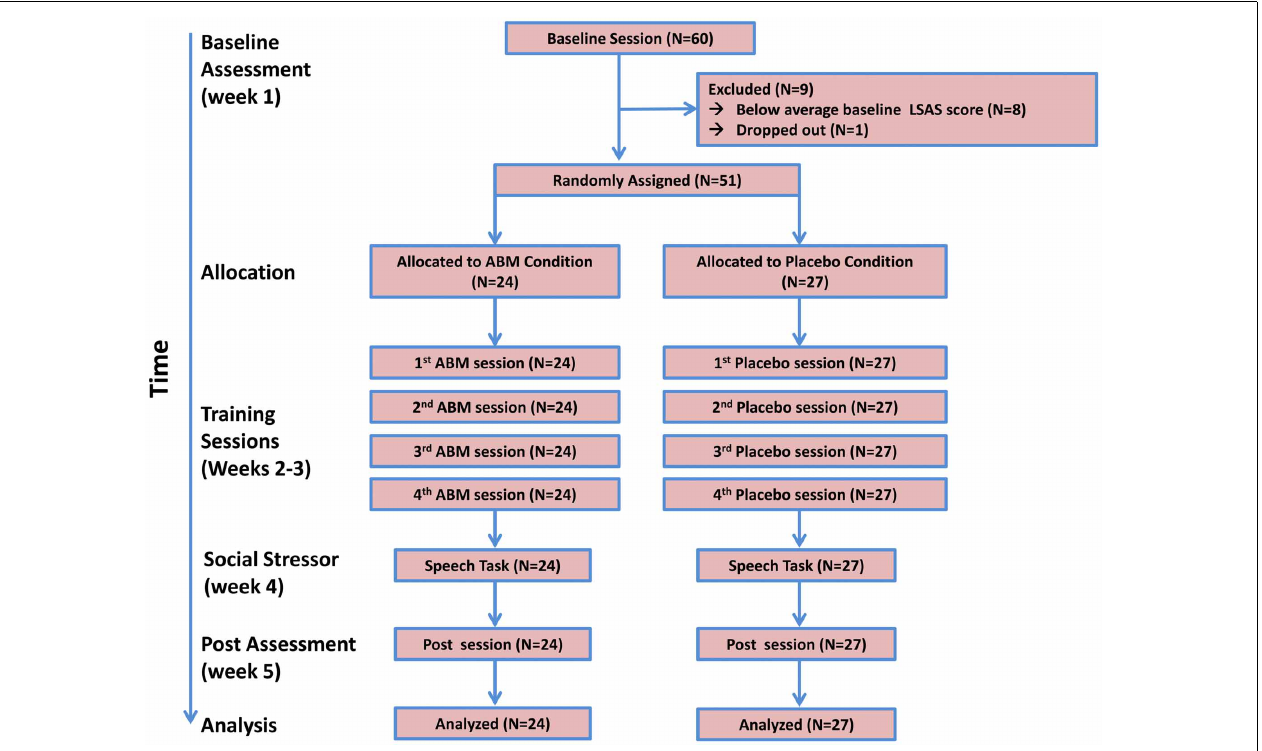
FIGURE 1 | CONSORT diagram and sequence of events in the study.